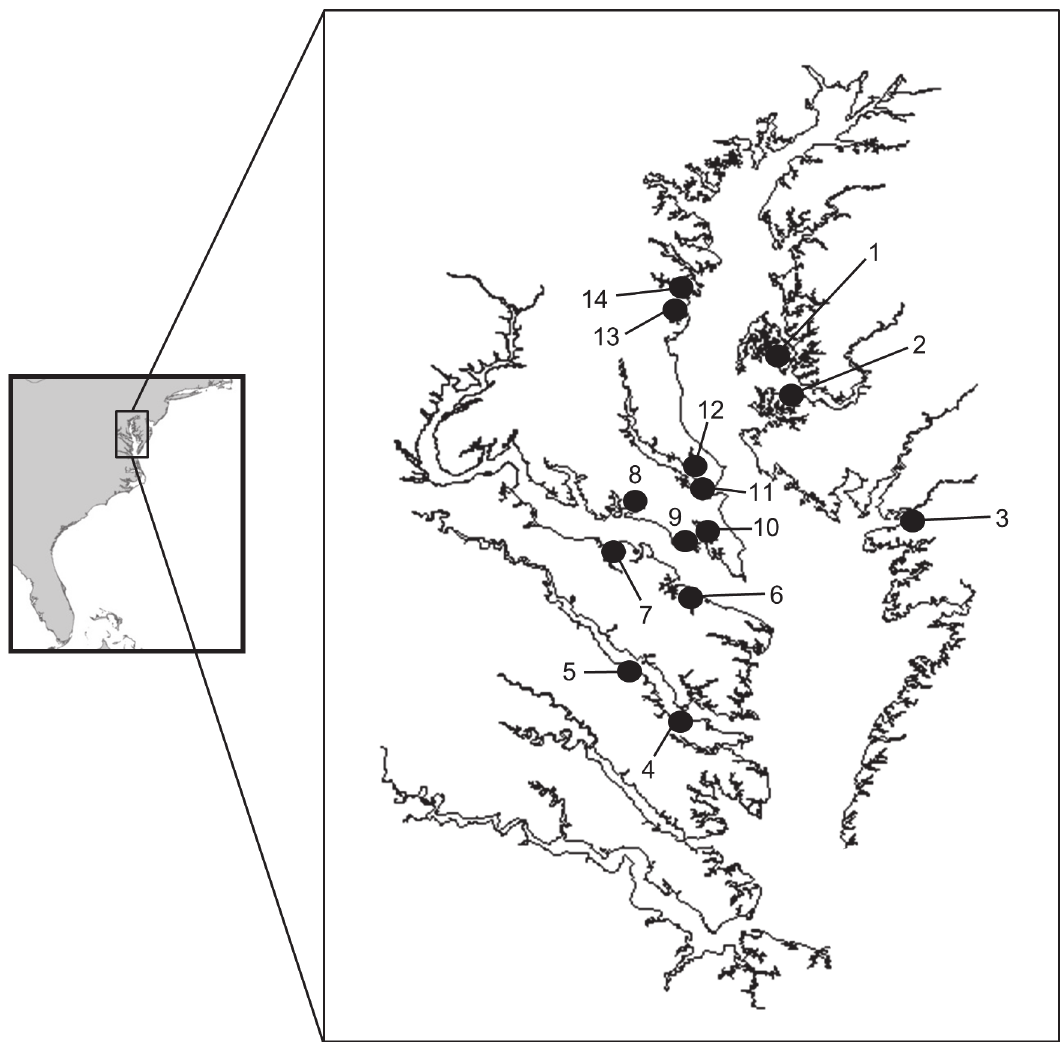
Fig 2. Oyster deployment locations for field experiments. (1) Choptank R. at Mulberry Pt., (2) Choptank R. at Univ. MD Horn Pt. Laboratory, (3) Little Monie Creek, (4) lower Rappahannock R., (5) middle Rappahannock R., (6) West Yeocomico R., (7) Nomini Creek, (8) Potomac R. at Breton Bay, (9) St. George ’ s Cr.(Potomac R.), (10) St. Mary ’ s R., (11) Patuxent R., (12) Cole ’ s Creek, (13) Rhode R., (14) Harness Creek (South R.). See S1 Table for GPS coordinates and year